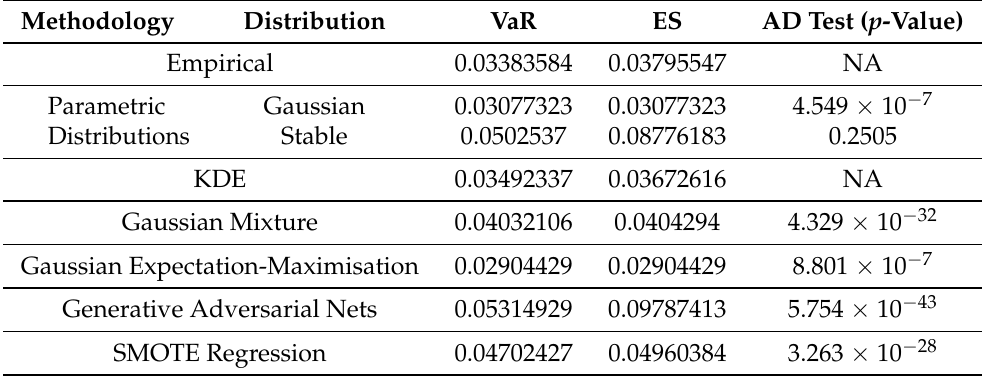
Table 2. Risk Measures Comparison. The Anderson–Darling (AD) test p -value has been added so as to assess the point-in-time goodness-of-fit of the distributions obtained with the methodologies presented in this